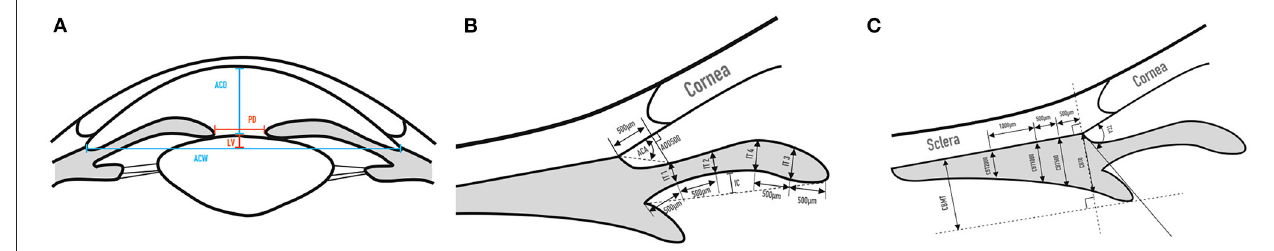
FIGURE 1 | UBM measurement parameters of the anterior segment. (A) ACD, ACW, LV, PD; (B) AOD500, ACA, IT1, IT2, IT3, IT4, IC; (C) TCA, CBT0, CBT500, CBT1000, CBT2000, CBMT.